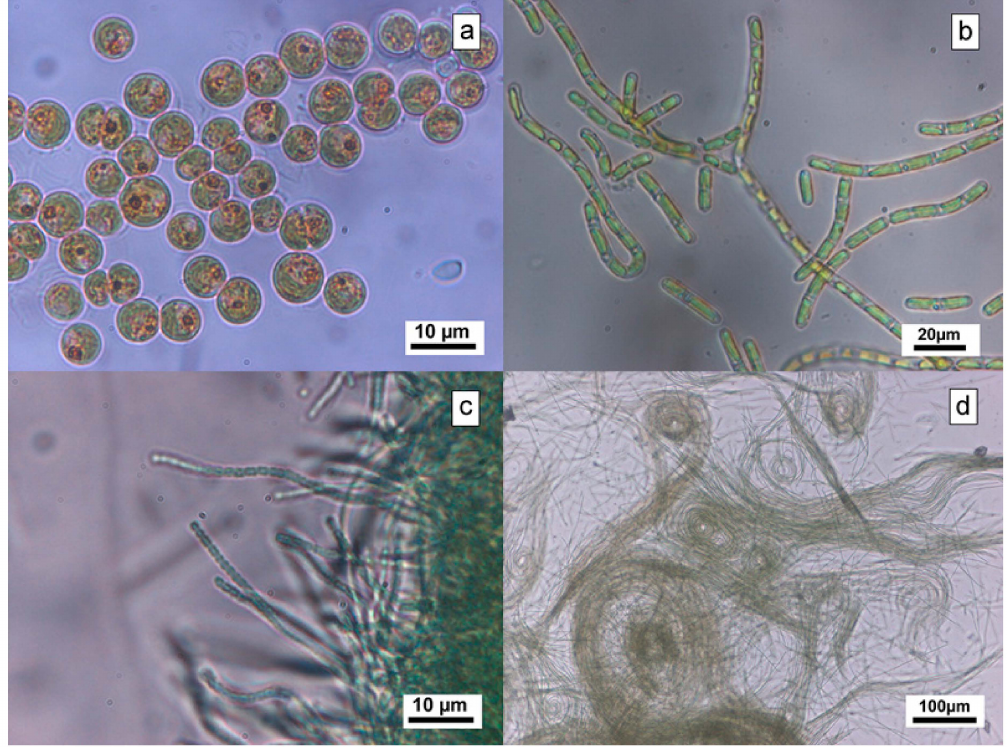
Figure 9. Photographs of the algal cultures Bracteacoccus sp. ( a ) and Klebsormidium sp. ( b ) and two di ff erent species of Leptolyngbya ( c , d